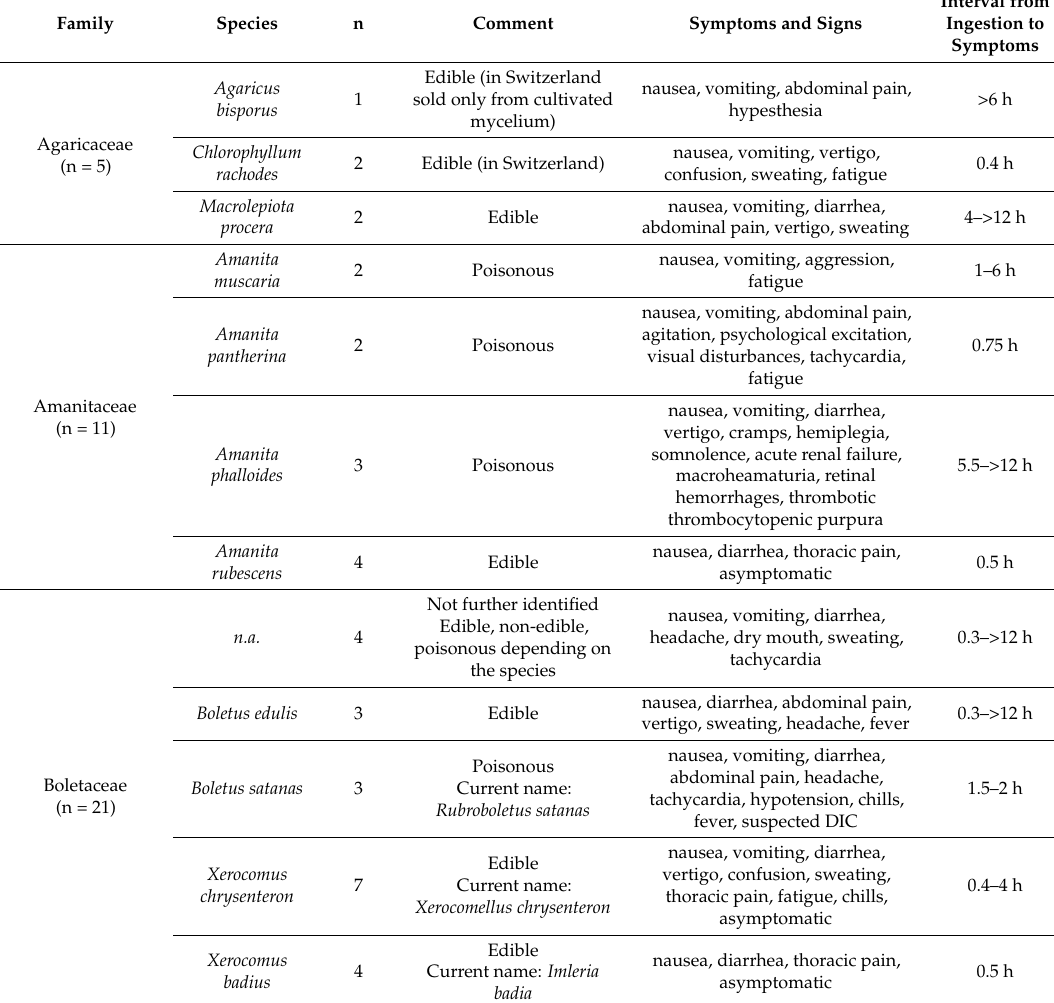
Table 2. Family [18–28], symptoms/signs and interval from ingestion to symptoms of identified and not definitely identified mushrooms (n = number of cases; more than one mushroom involved in some